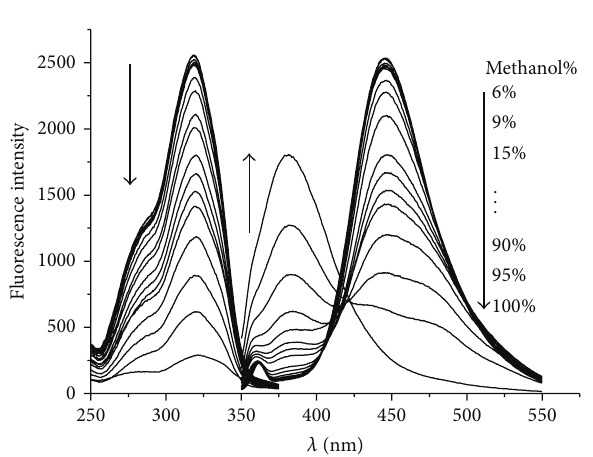
Figure 4: Fluorescence spectra of 4MU in aqueous solutions containing different amounts of methanol. 𝑐 4 / 𝜆 : 320 5.98; 𝜆 ex em